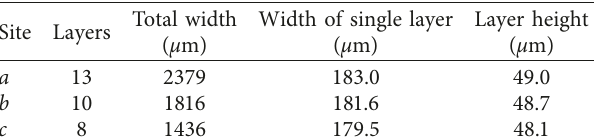
Figure 7: Surface topography of the upwards facing surface of the XY + 45B specimen from set 1 at the (a) top; (b) middle; and (c) bottom of the tensile sample. Table 7: Layer and edge step